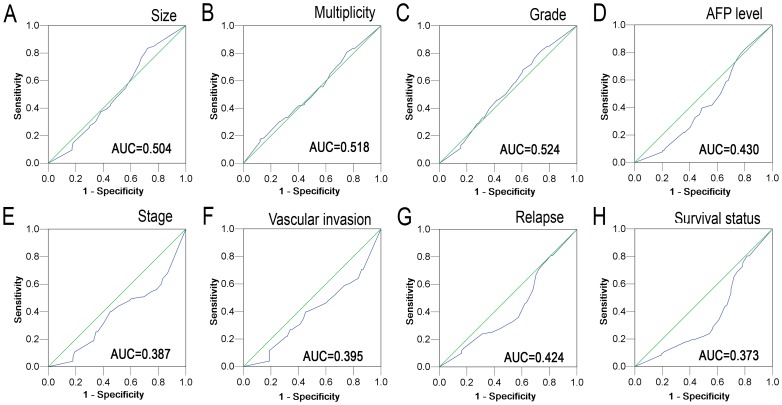
Immunohistochemical staining of PTPN12 protein in HCC and noncancerous liver tissues.
A. Normal expression of PTPN12 was observed in a HCC case, showing strong diffuse cytoplasmic immunoreactivity of PTPN12 (upper panel, ×100; lower panel, ×400). B. A HCC case showed decreased expression of PTPN12, in which all of cancer cells showed weak staining of PTN12 (upper panel, ×100; lower panel, ×400). C. Negative expression of PTPN12 was detected in a HCC case (upper panel, ×100; lower panel, ×400). D. Normal expression of PTPN12 was observed in adjacent liver tissues, in which all of cancer cells showed strong staining of PTPN12 (upper panel, ×100; lower panel, ×400).